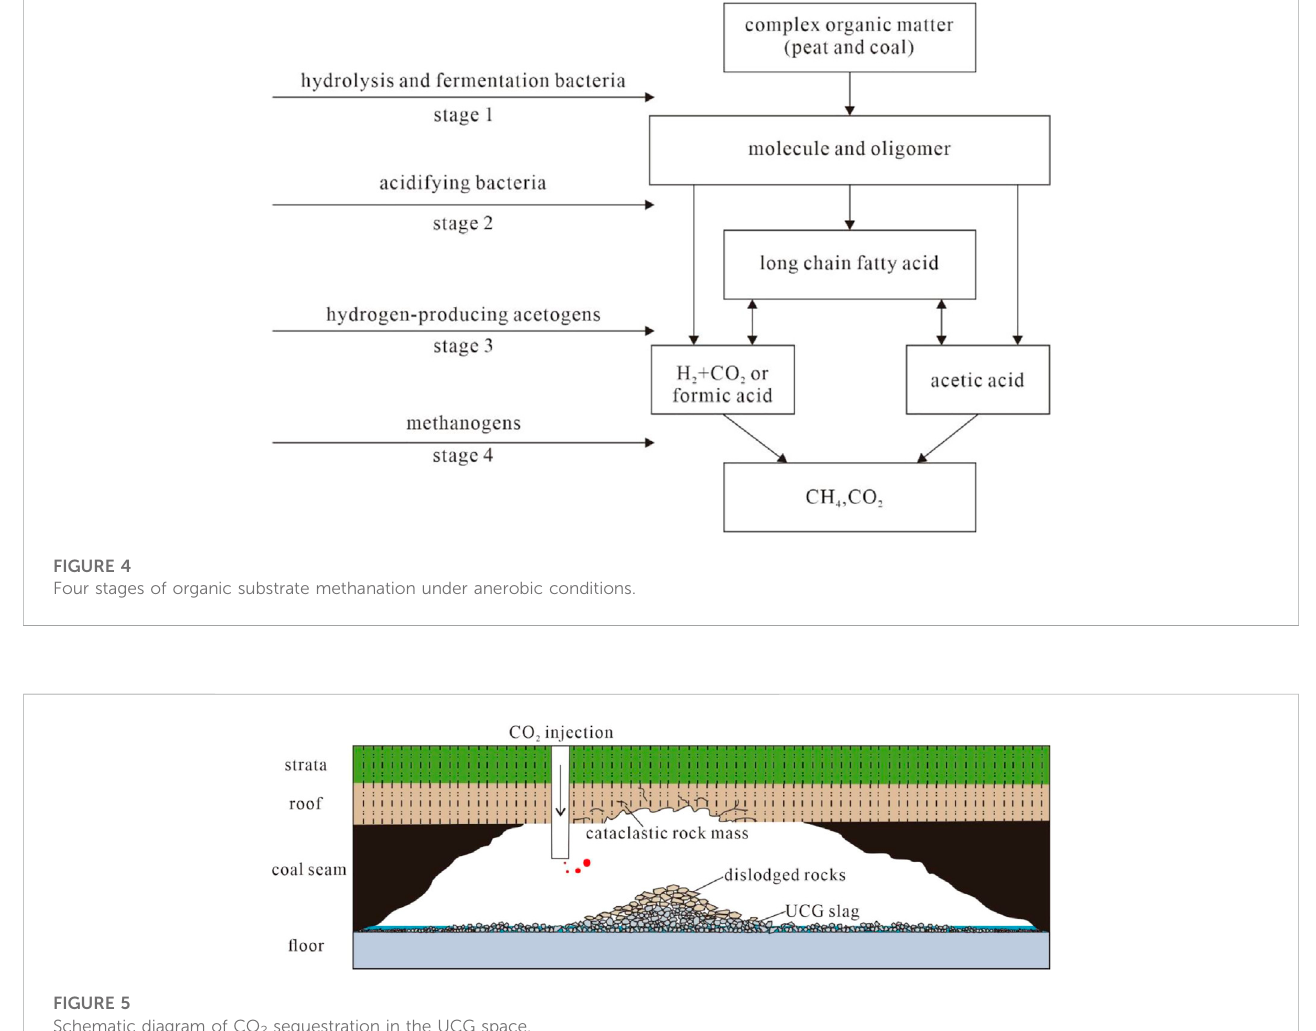
FIGURE 5 Schematic diagram of CO 2 sequestration in the UCG